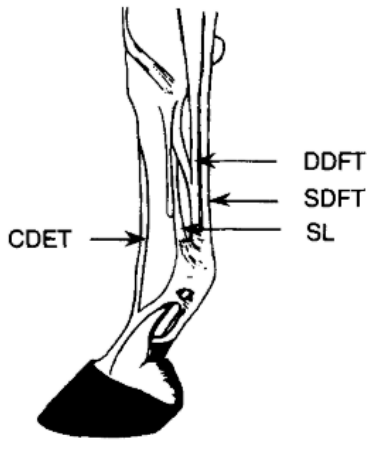
Figure 2. Anatomy of forelimb tendons frequently studied [51]: common digital extensor tendon (CDET), deep digital flexor tendon (DDFT), superficial digital flexor tendon (SDFT), and suspensory ligament (SL).